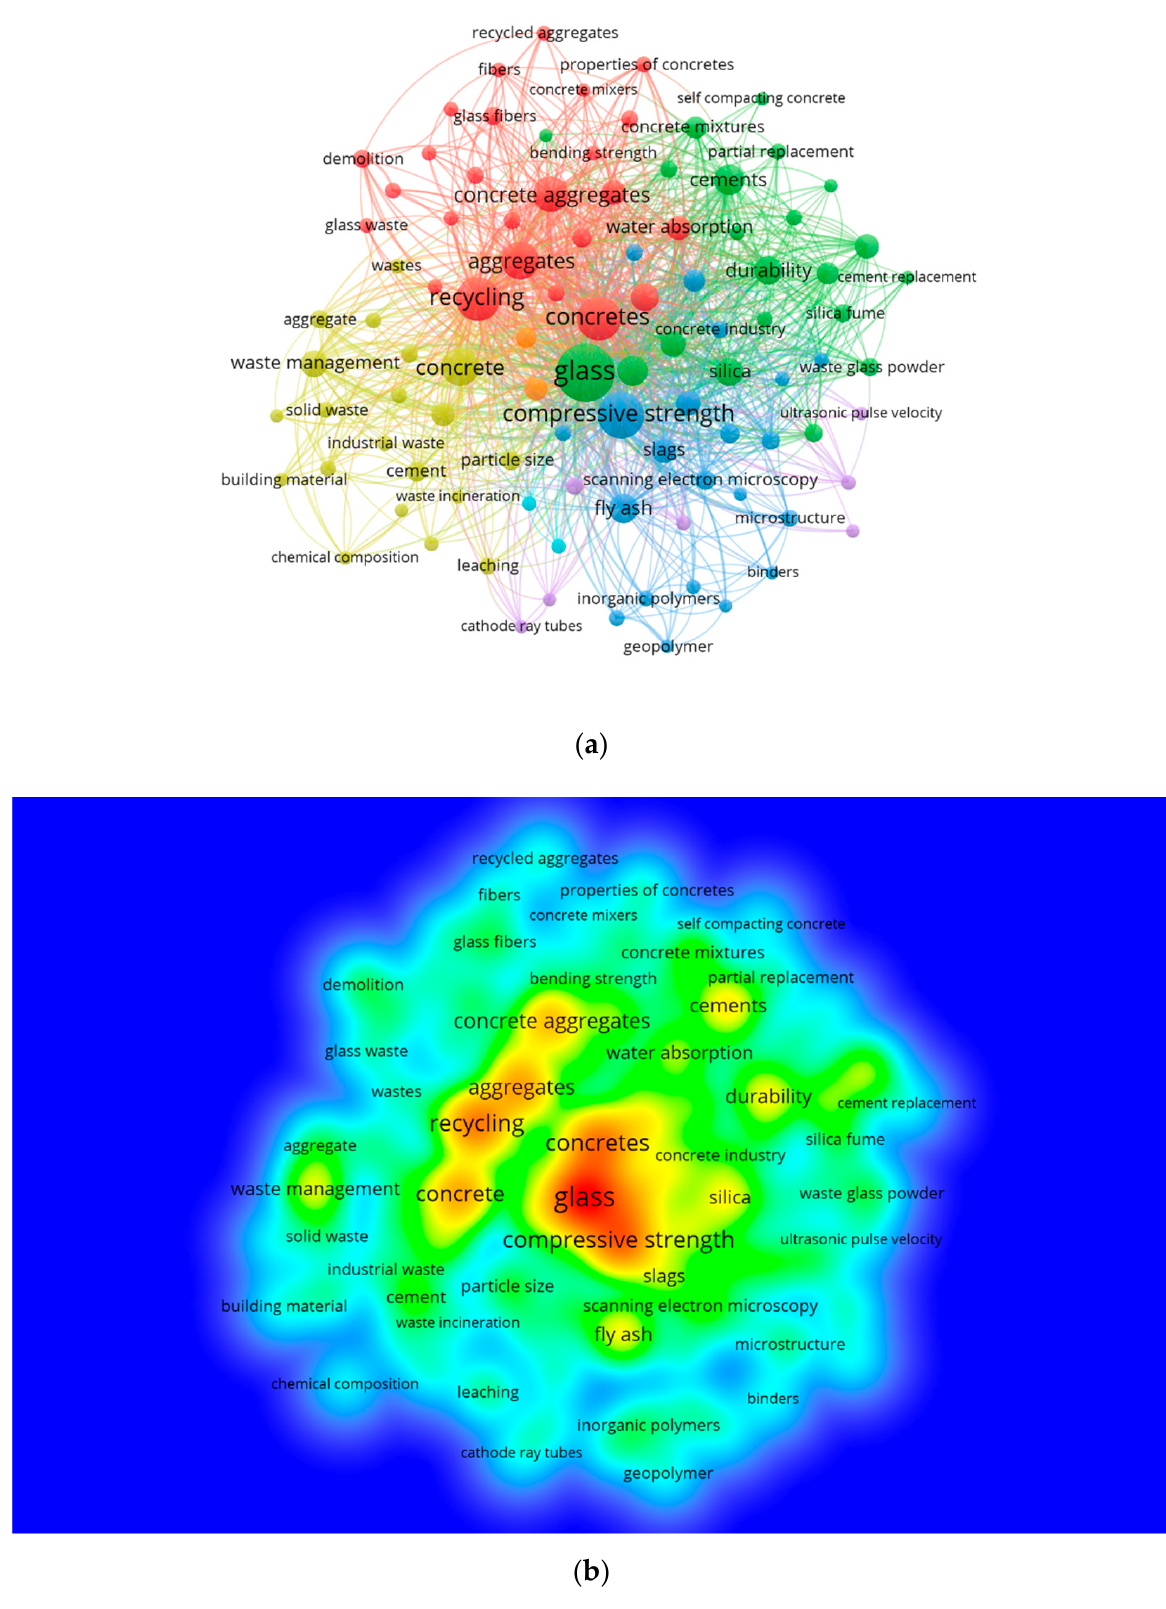
Figure 5. Mapping of keywords: ( a ) co-occurrence visualization; ( b ) density visualization.